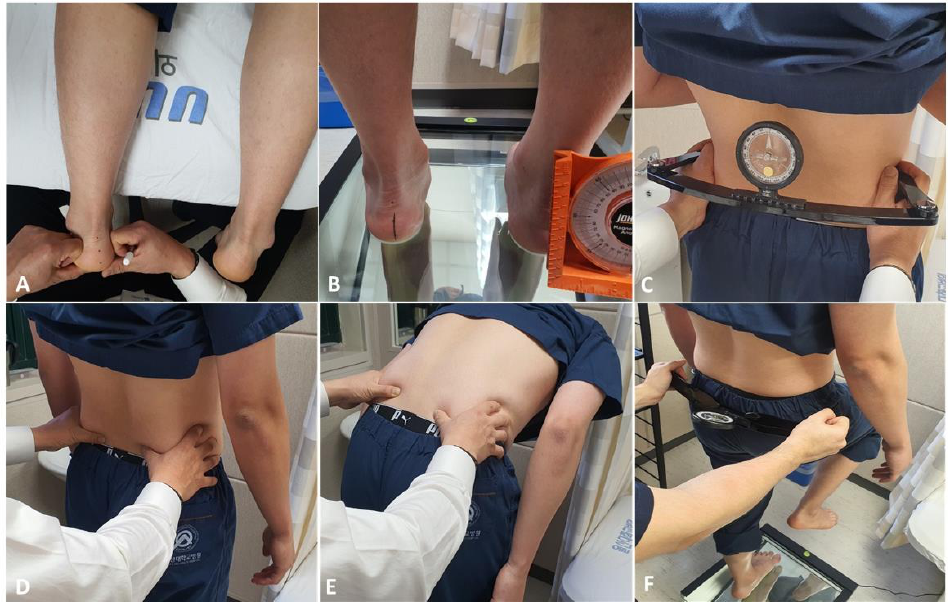
Figure 1. Measurement of the resting calcaneal stance position (RCSP), pelvic elevation, pelvic tilt, and pelvic rotation. Measurements of the ( A ) RCSP in the prone position, ( B ) RCSP in the standing position, ( C ) pelvic elevation, ( D , E ) pelvic tilt, and ( F ) pelvic rotation.